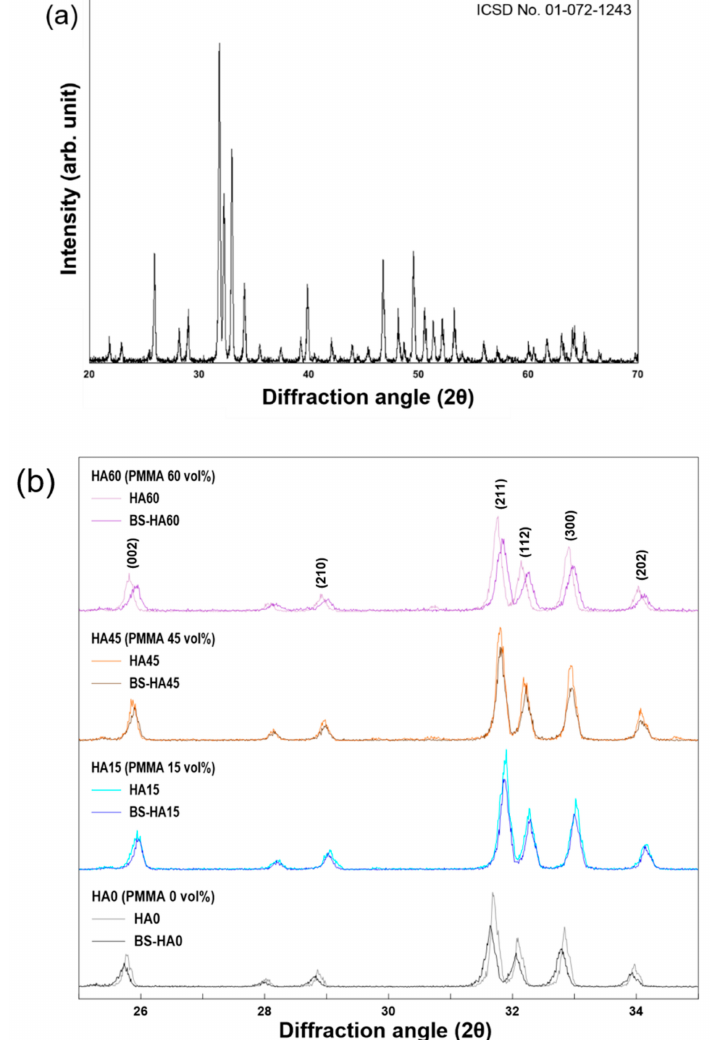
Figure 2. XRD patterns of ( a ) hydroxyapatite (HA) powder and ( b ) HA sca ff olds before and after sintering (“BS” means “before